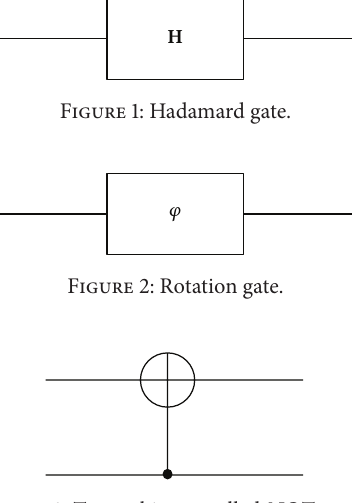
Figure 1: Hadamard gate.